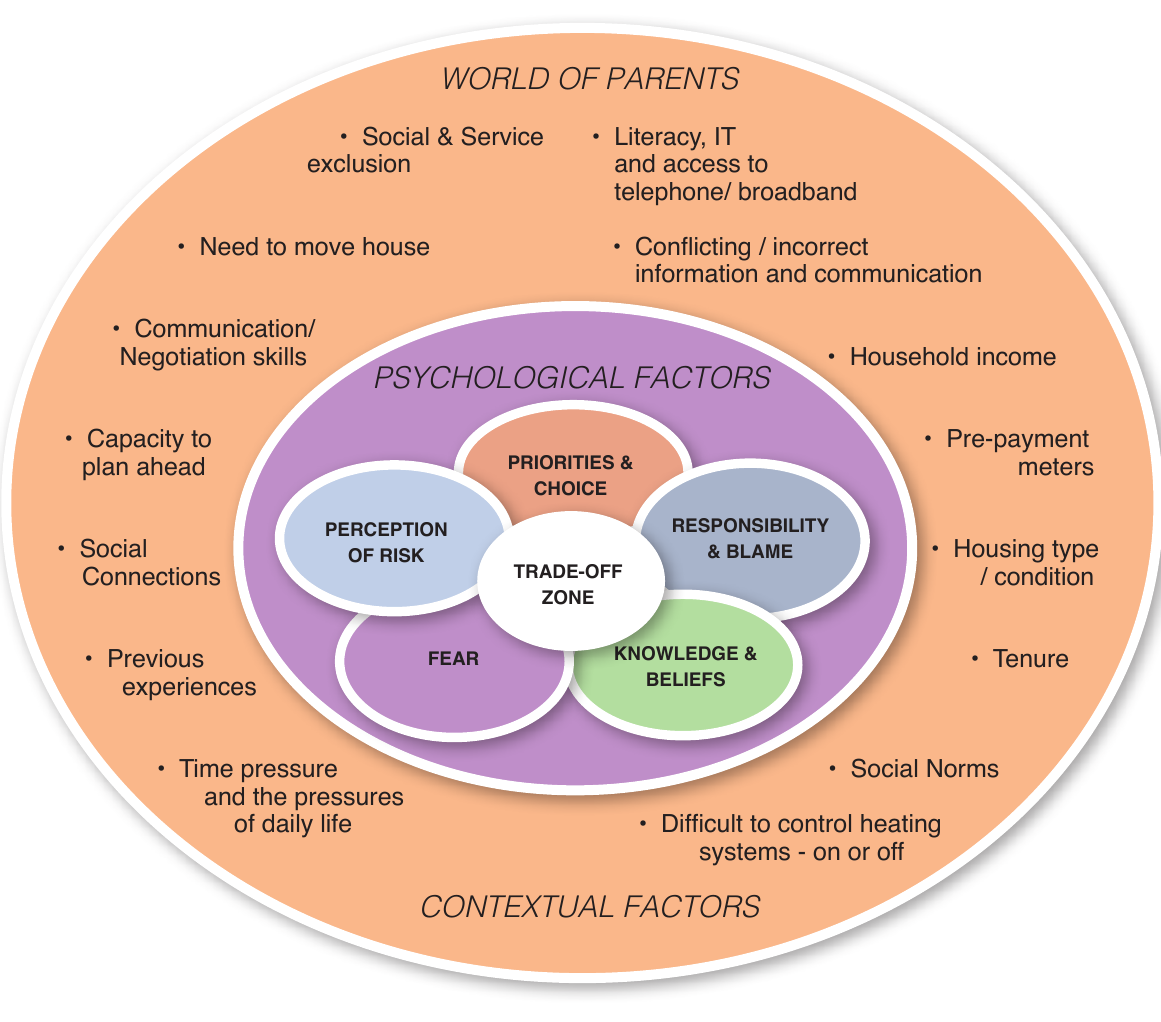
Figure 6: The trade-off zone